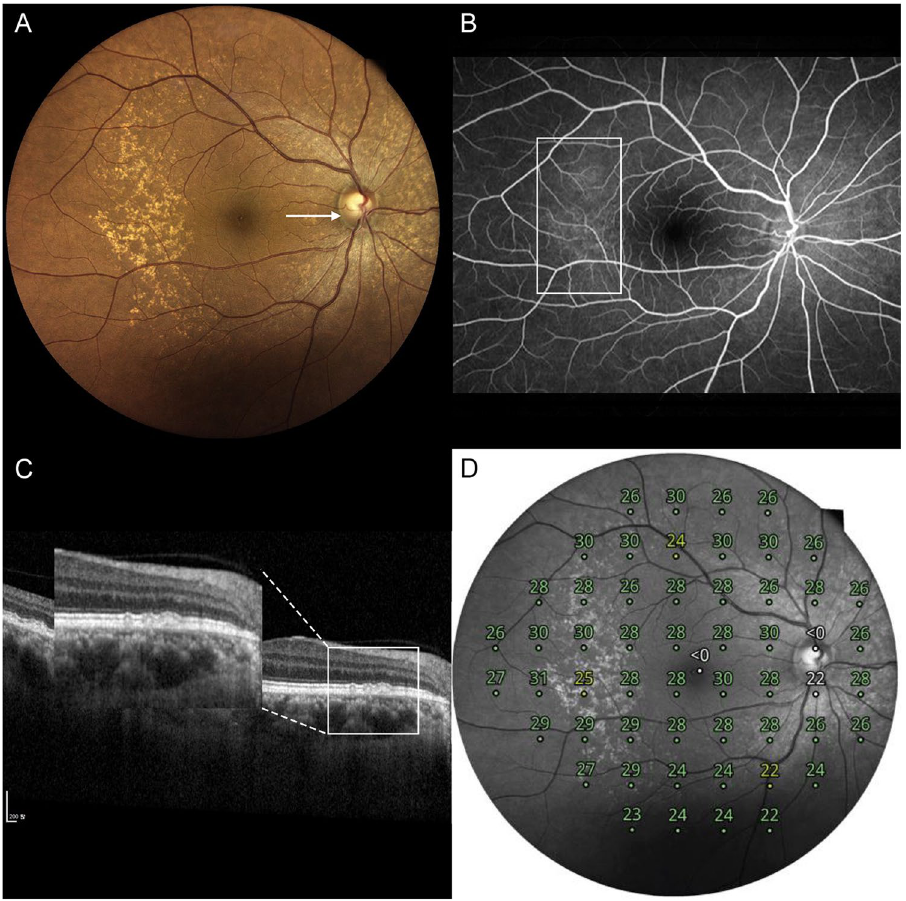
Figure 2. A representative case of type 1 cuticular drusen. A 57-year-old woman presented with type 1 cuticular drusen. ( A ) Color fundus photography showed numerous cuticular drusen. The cuticular drusen area was scanned using spectral-domain optical coherence tomography (SD-OCT) (arrow). ( B ) Fundus fluorescein angiography showing hyperfluorescent drusen. This can confirm the diagnosis of cuticular drusen. ( C )